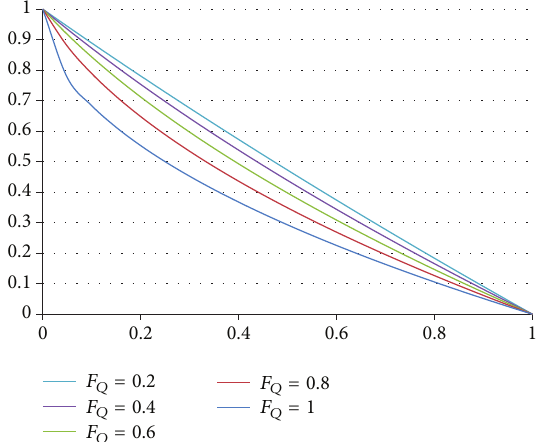
Figure 4: Demand allocation fraction to the upstream node depending on the location of a single withdrawal in the